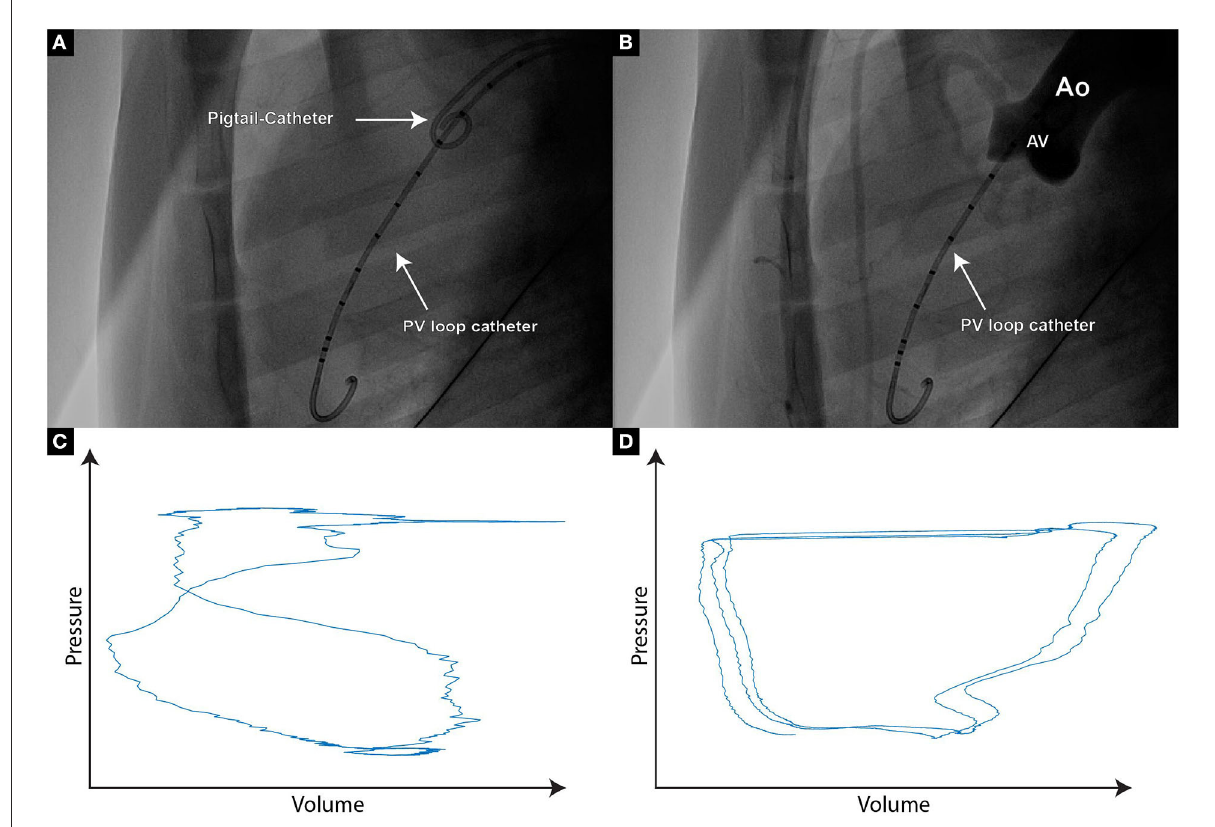
FIGURE1 (A) Fluoroscopic image of a PigTail catheter which is positioned in the aortic valve cusp, hence enabling the assessment of PV loop catheter segments that are reliably positioned within the left ventricle; (B) If uncertainty regarding the PV loop segments within the left ventricle persists, contrast agent can be delivered through the PigTail catheter, hence providing an aortographic image clearly demonstrating the separation between the aorta and the left ventricle; (C) Typical “figure of 8” PV signal originating from the segment placed at the level of the aortic valve or above. Such segments should not be taken into further analysis; (D) Paradox composite PV loop curves demonstrating volume increase during systole and volume decrease during diastole. If such curves occur, re-positioning of the PV loop catheter needs to be